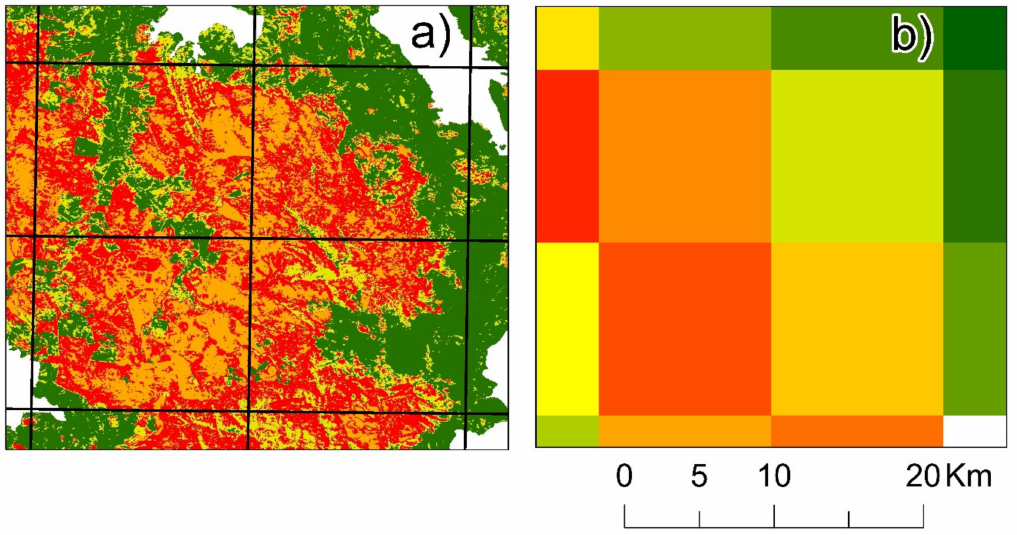
Figure 3. An example of aggregated data. ( a ) RdNBR index calculated using 30-m Landsat TM data; ( b ) RdNBR pixels aggregated to match spatial resolutions of meteorological